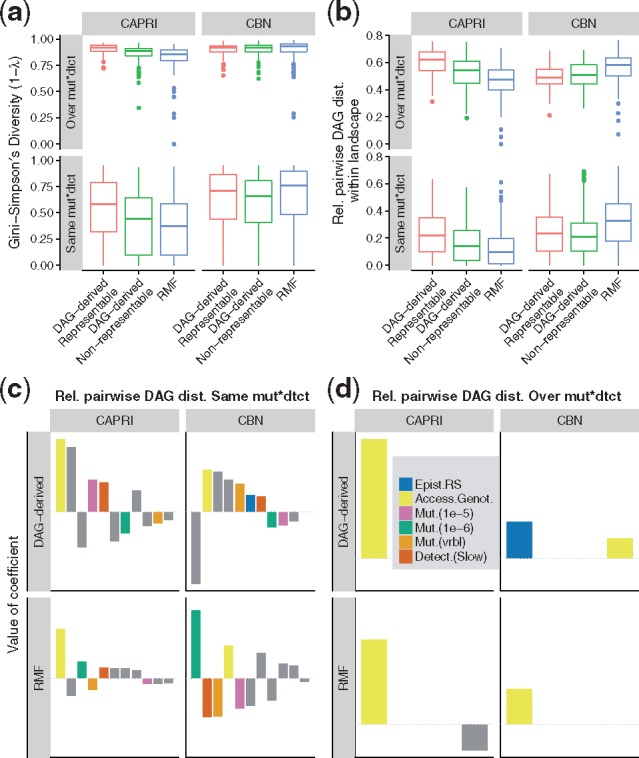
Variability of DAGs of restrictions inferred from a landscape. “Same mut×dtct”: values from the 20 replicates under each combination of landscape by mutation rate by detection. “Over mut×dtct”:20 × 6 replicates of a landscape over the 3 mutation by 2 detection regimes. (a) Gini-Simpson’s diversity index, the probability that two DAGs from the given scenario are different. (b) Relative pairwise DAG distance (see Section 2). The value shown for a landscape is the average relative pairwise DAG distance for all pairs of inferred DAGs for a landscape. (c, d) Coefficients from linear models; see legend of Figure 2. In panel (d) only accessible genotypes, reciprocal sign epistasis and their interaction could, by design, be examined